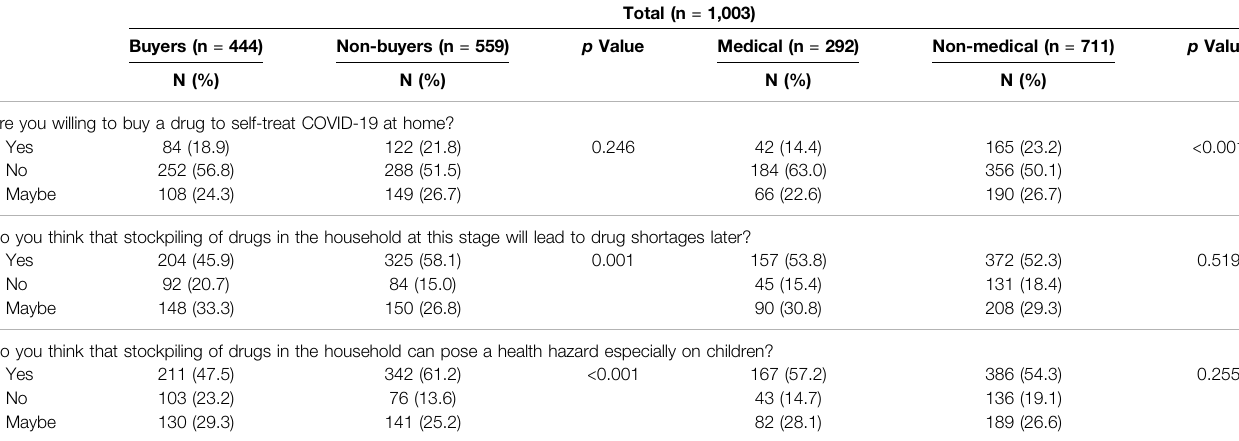
TABLE 3 | Participants ’ knowledge about self-medication with COVID-19 drugs and risk of drug